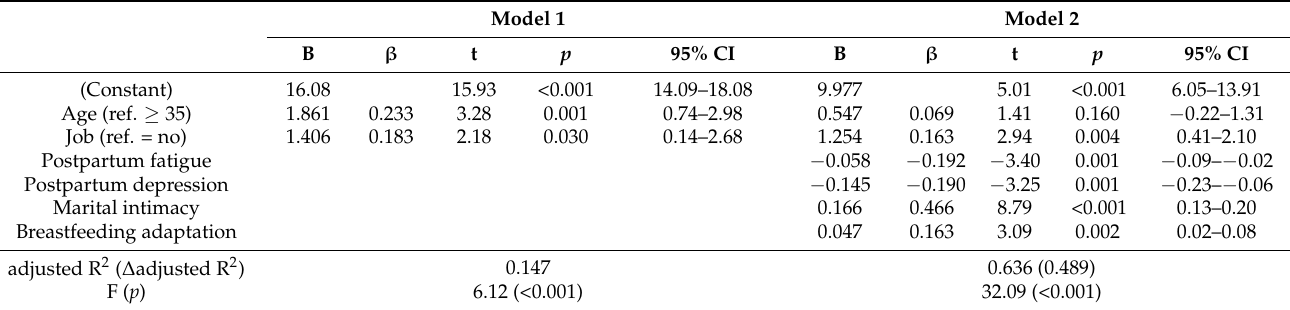
Table 5. Factors Influencing the Quality of Life of